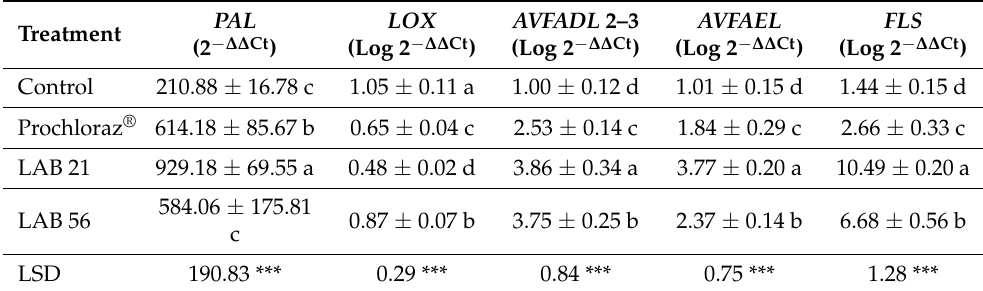
Table 1. Expression of antifungal defense genes in curatively inoculated avocado fruit treated with LAB strains. PAL LOX Treatment (2 − ∆∆ Ct ) Control 210.88 ± 16.78